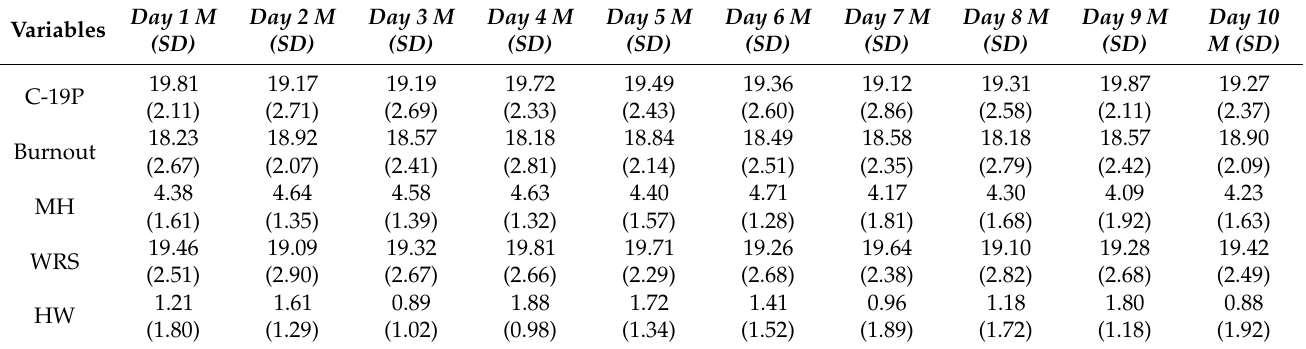
Table 1. Mean and SD for all study variables for each of the 10